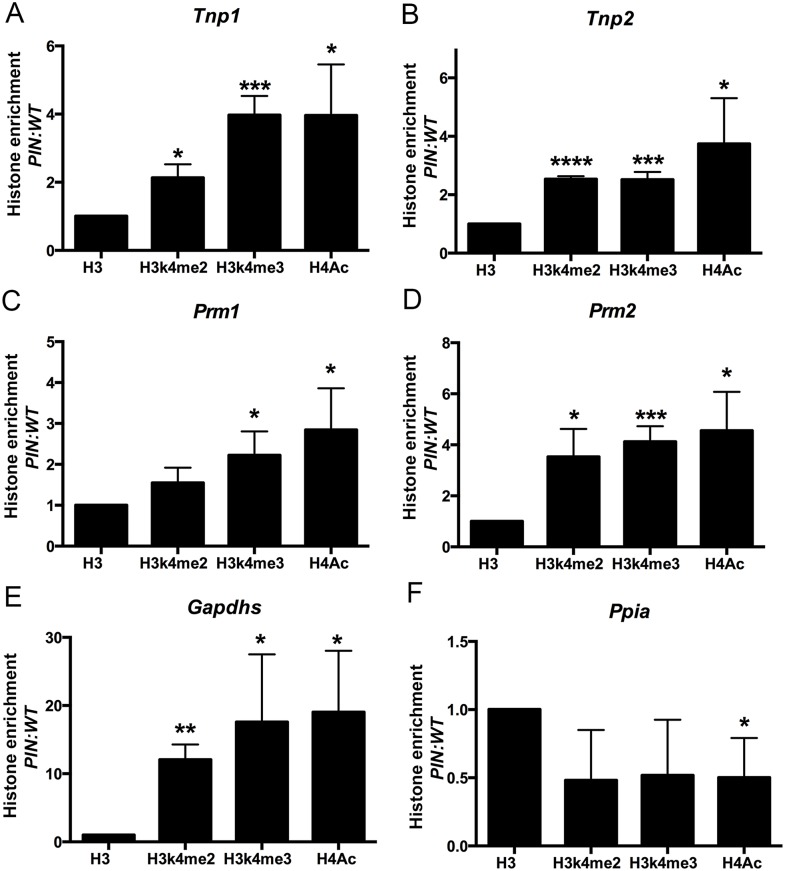
Enrichment of active histone mark at the promoter regions of spermiogenic genes in Henmt1
PIN/PIN spermatocytes.ChIP and qPCR analyses were performed on Henmt1
WT/WT and Henmt1
PIN/PIN spermatocytes (n = 5/genotypes, 3 biological replicates, * p<0.05, **p<0.01, *** p<0.001, **** p<0.0001). qPCR for the promoter regions of (A) Tnp1, (B) Tnp2, (C) Prm1, (D) Prm2, (E) Gapdhs, and (F) Ppia (as a house keeping control). Histone enrichment was normalised to histone H3. The data is presented in the ratio of Henmt1
PIN/PIN enrichment/ Henmt1
WT/WT enrichment. A two-tailed unpaired student T-test was performed for statistical analyses.